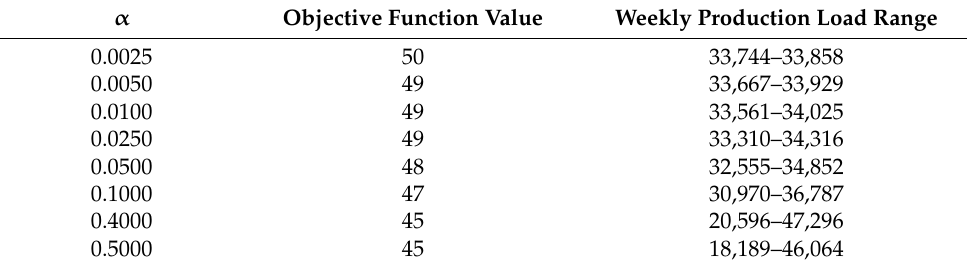
Table 8. Results of Case 3 at various values of α .